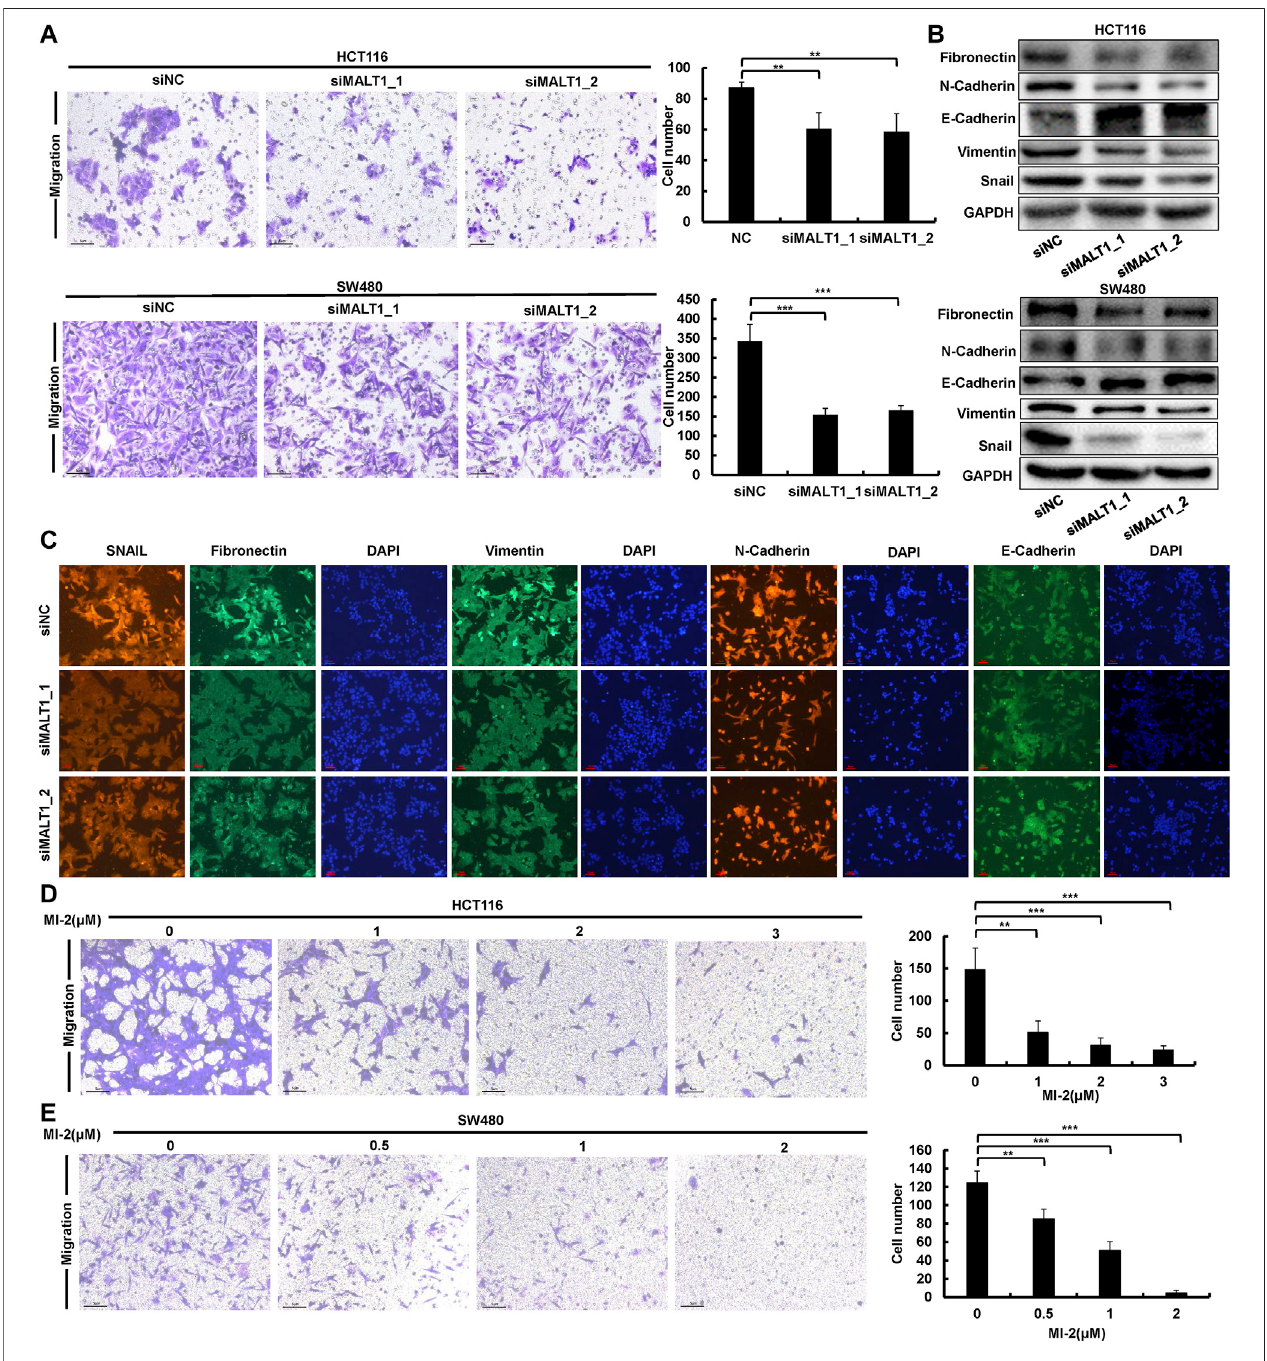
FIGURE3| DownregulationofMALT1inhibitedCRCcellmigration. (A) CellmigrationofCRCcellstransfected,asdescribed,wasdeterminedbytranswellassays. (B) EMT-associatedproteinlevelwasexaminedbyimmunoblottinginCRCcellsaftertransfection. (C) TheexpressionofEMT-associatedproteinwasdeterminedbyIFin HCT116 cell after transfection. MI-2 inhibited HCT116 (D) and SW480 (E) cell migration was detected by transwell assays. Each experiment was performed in triplicate anddataarepresentedasmean±SD.One-wayANOVAandDunnett ’ smultiplecomparisontestwereusedtoanalyzethedata(* p < 0.05,** p < 0.01,*** p < 0.001).